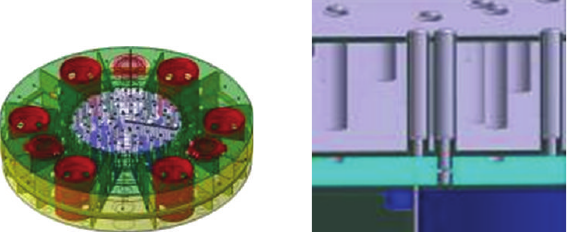
Figure 3: Integrated diagrid-strongback option (general view and strongback access